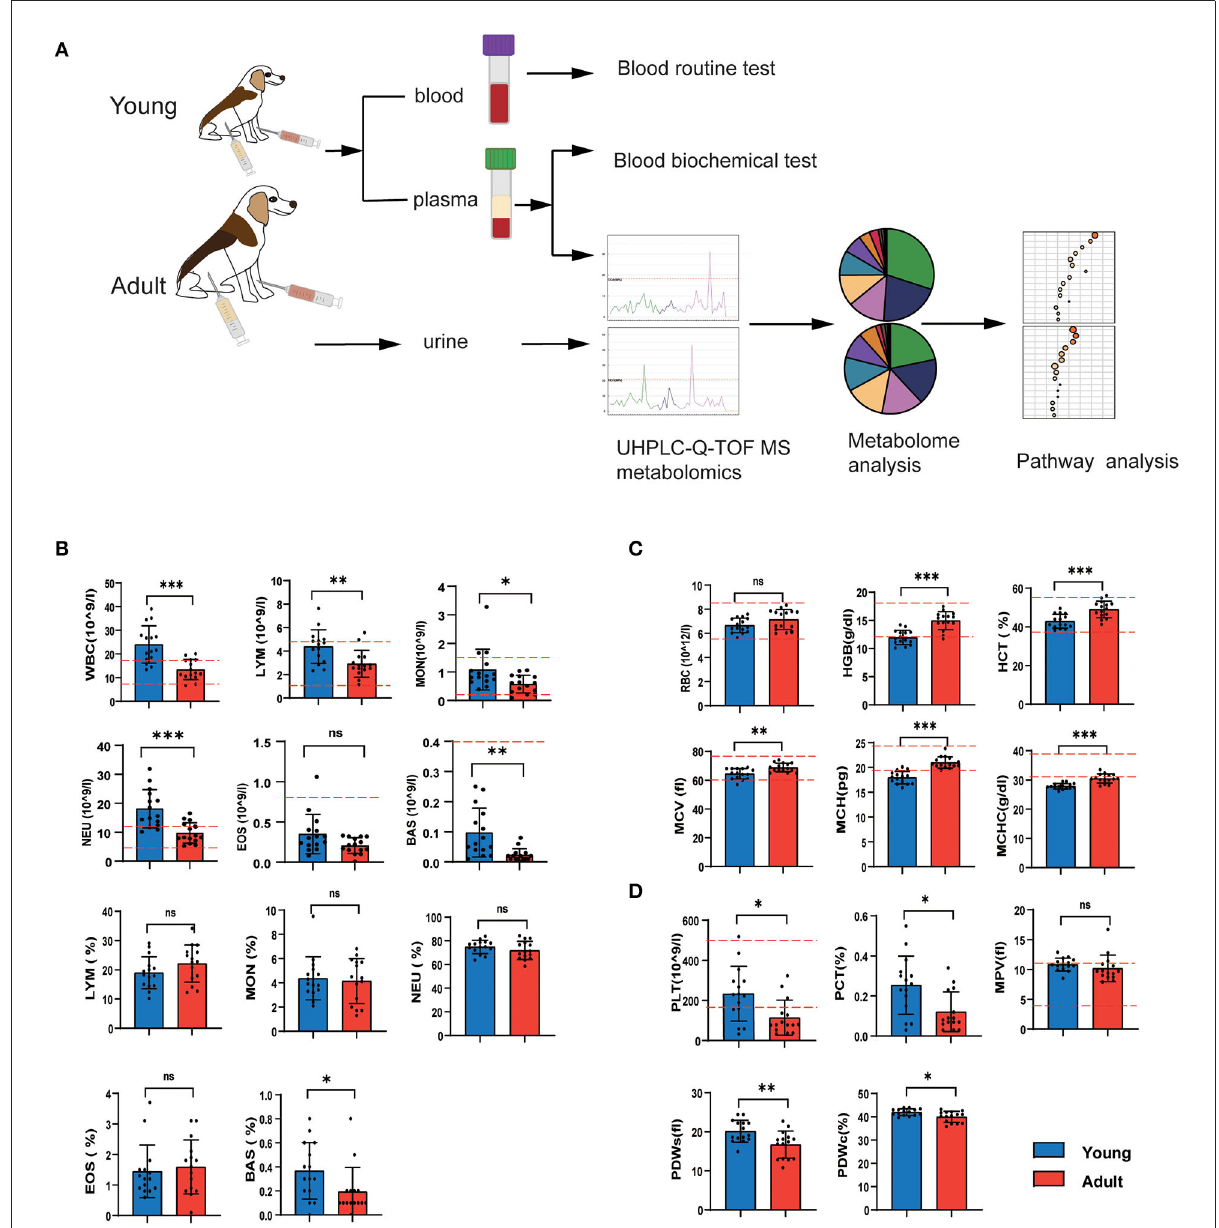
FIGURE1 Age-related changes in the number of blood cells. (A) Study flow diagram of tests of physiological and biochemical indexes, UHPLC-Q-TOF/MS detection, metabolite analysis and pathway analysis. (B–D) Routine blood texts of young and adult groups. The white blood cell-derived indexes (B) , red blood cell-related indexes (C) , platelet-derived indices (D) . Horizontal red dotted lines represent the normal range for each measured value. n = 15 dogs per group. Data are represented as mean and standard deviation. Adult group vs. young group: * P < 0.05, ** P < 0.01, *** P < 0.001, and ns indicates not significantly